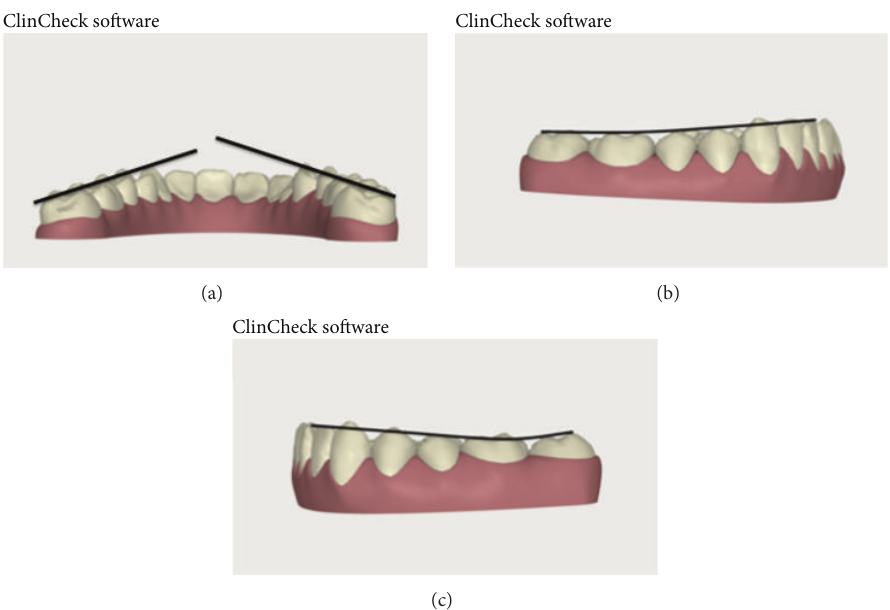
Figure 4: (a) Curve of Wilson; (b) curve of Spee in the right side; and (c) curve of Wilson in the left side.